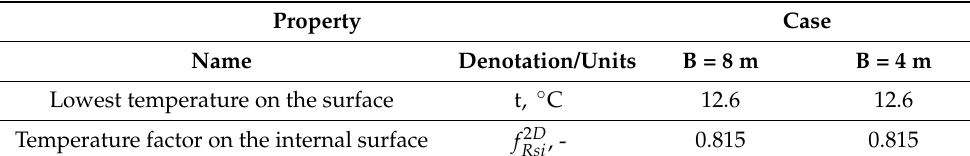
Table 5. Results of temperature coefficient calculations.